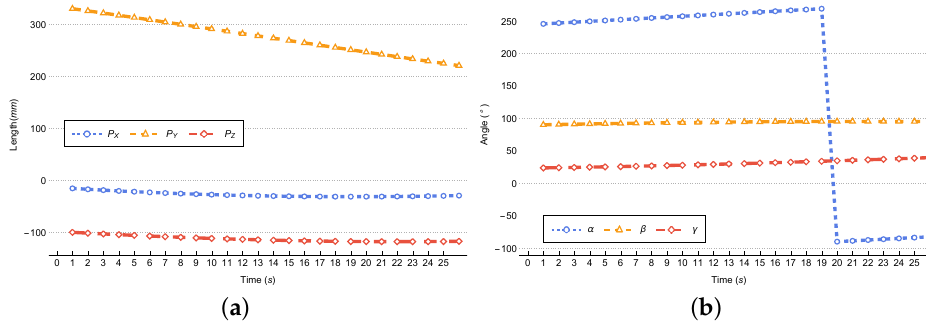
Figure 13. A sample of workspace. ( a ) Position ( P X , P Y , P Z ). ( b ) Orientation ( α , β , γ ).